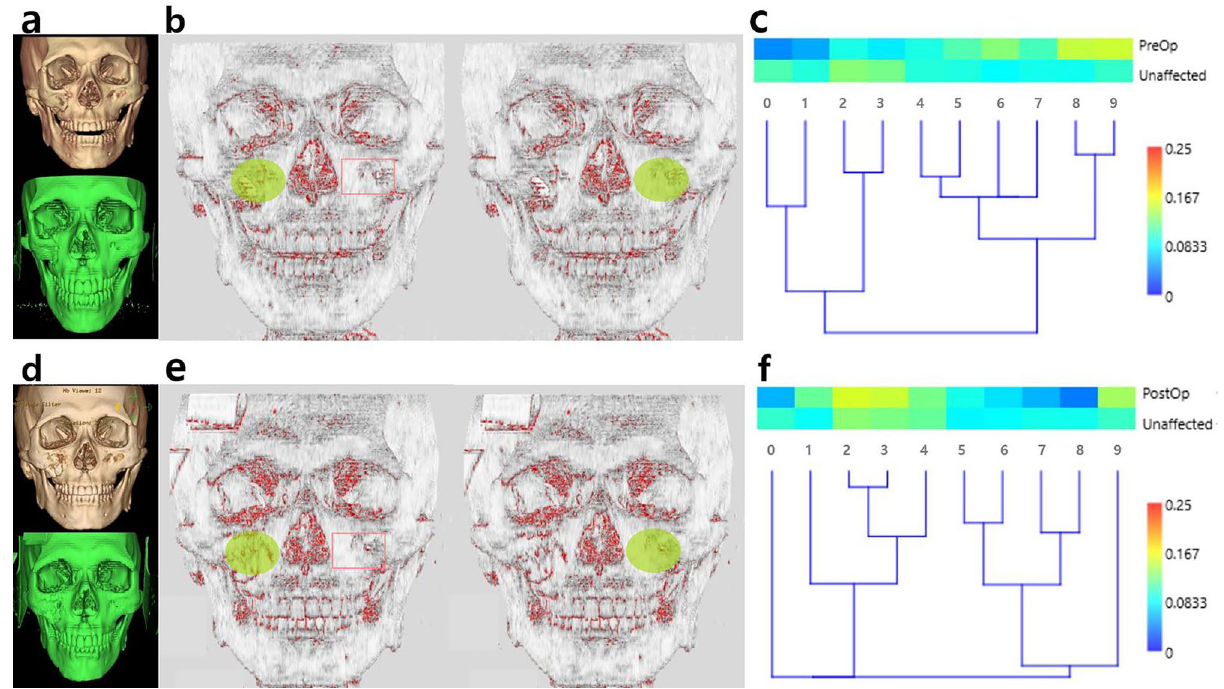
Figure 4. Similarity analysis of the anterior maxilla using BCSI and hierarchical clustering. ( a ) Fractured right anterior maxilla was presented in DICOM and OBJ images. ( b ) The subject areas on affected and unaffected sides were displayed in fluorescent green. ( c ) The BCSI was 0.81, and the discrepancy between both sides showed notable components using the color spectrum chart. ( d ) The fracture site was reduced postoperatively. ( e ) The subject areas were selected in postoperative images. ( f ) The postoperative BCSI was 0.87 showing increment compared to the preoperative value, 0.81. The differences were improved in comparison with the preoperative